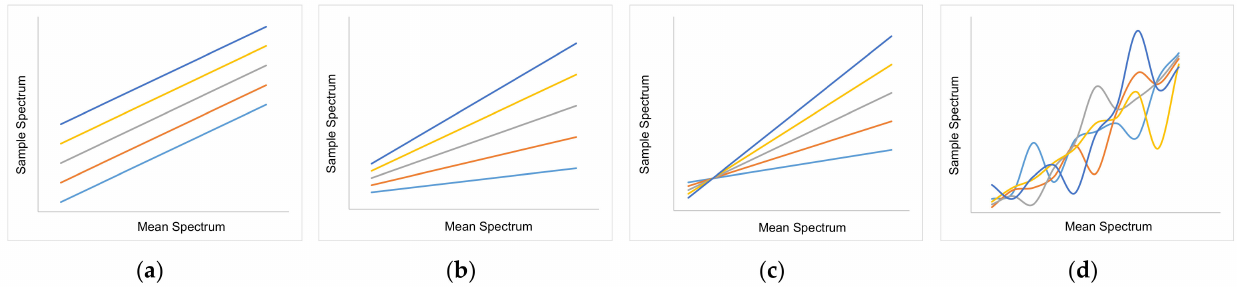
Figure 3. Exemplary scatter effects plots of ( a ) additive effects, ( b ) scatter effects, ( c ) additive and scatter effects, and ( d ) complex effects. Colors indicate spectra from different